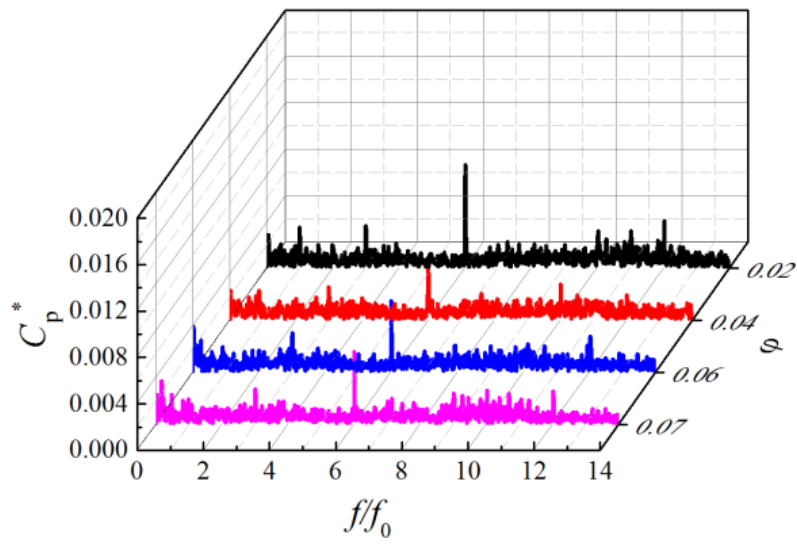
Figure 4. Frequency domain of pressure fluctuation for different flow rates and α = 0.